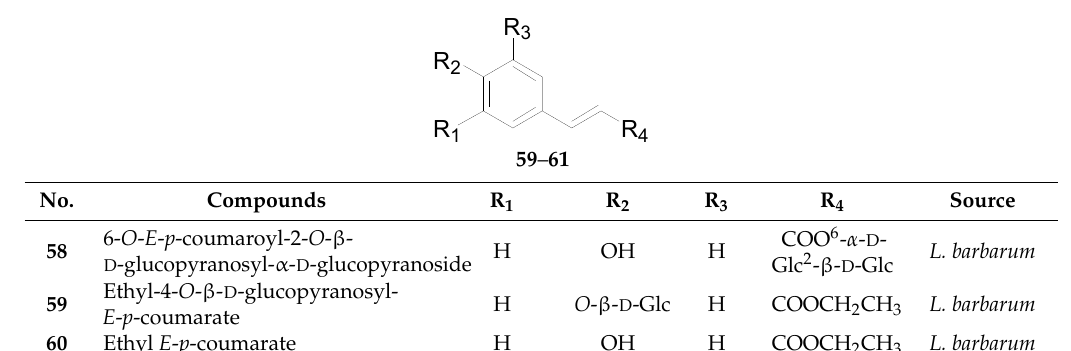
Figure 4. Chemical structures of compounds 52 – 57 , 61 . Table 5. Chemical structures of compounds 58 – 60 .